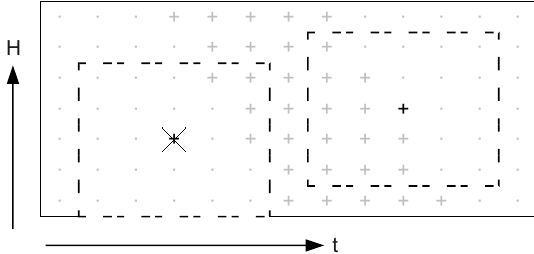
Fig. 6. Time-height plot of radar observations without ( · ) and with identified peak ( + ). While the left peak, marked with a black + , is removed because only 4 of 24 neighbours (dashed box) contain a peak as well, the right black + is confirmed as a peak, because 11 of 24 neighbours contain a peak as